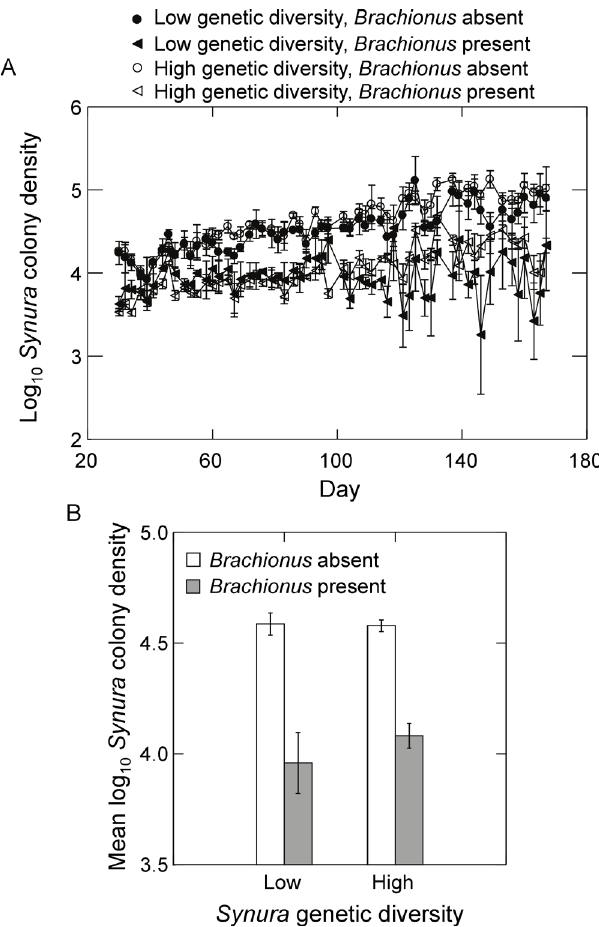
Figure 7. Effects of initial Synura genetic diversity (low versus high) and Brachionus presence/absence on ( A ) Synura colony densities over time (shown are means across replicates, +/-S.E.), and ( B ) Synura colony densities averaged over days 51 to 167 (means, +/-S.E.).Original units in numbers of colonies per mL.